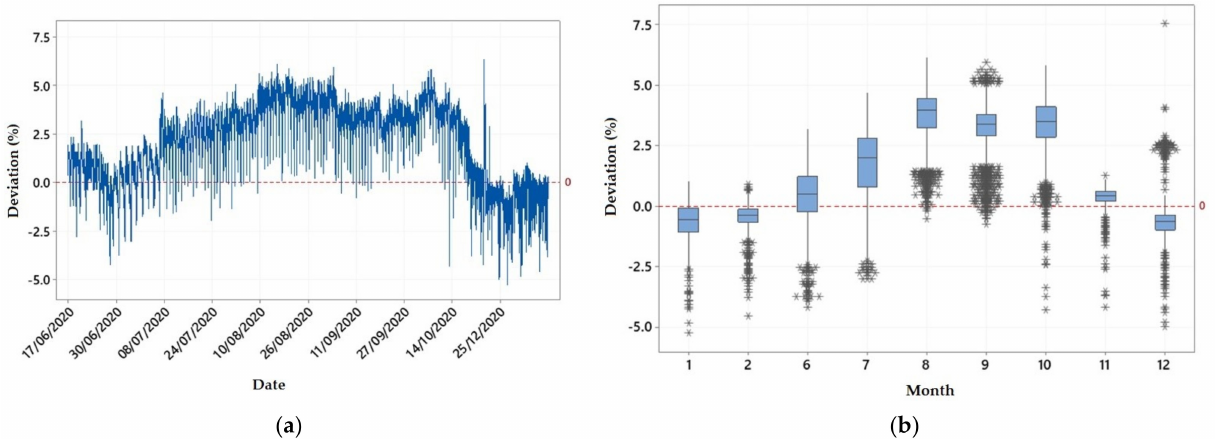
Figure 4. Percentage deviations of the measured pressure transducer water stages from the ultrasonic stages at Pikrodafni stream: ( a ) throughout the common period with available data from both sensors and ( b ) per month (nine months of available data).